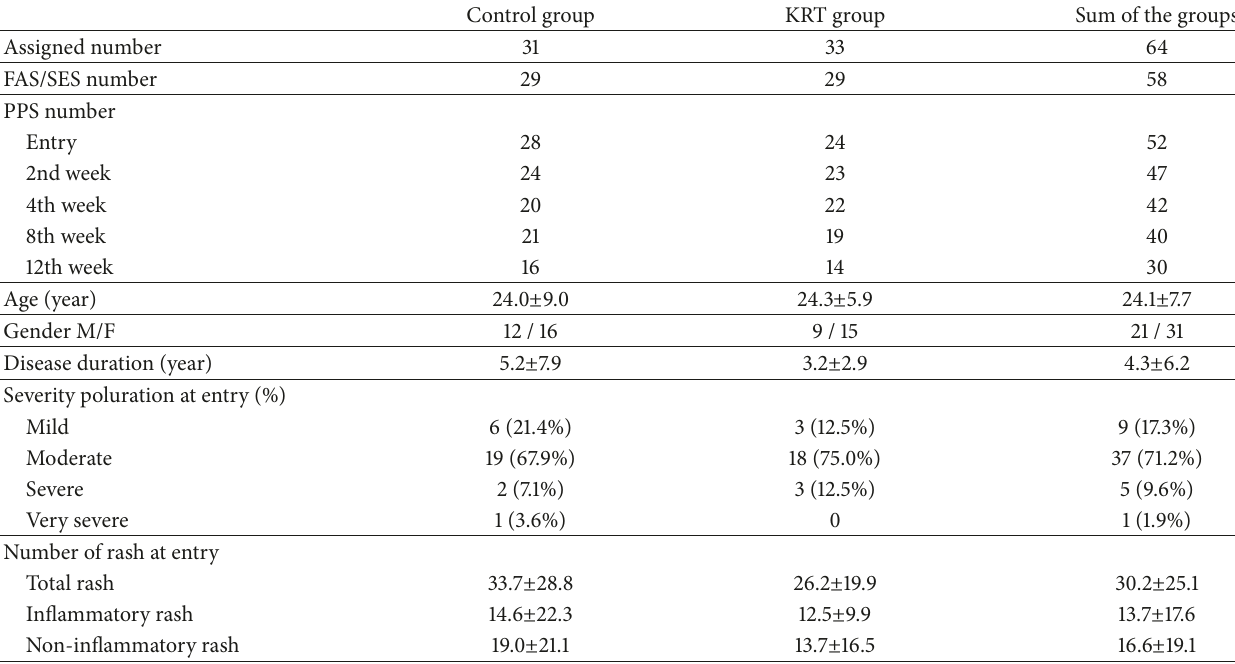
Table 1: Background and number of acne patients.